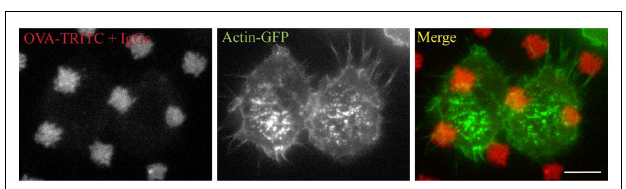
FIGUREA1 | Fc-receptors are necessary to trigger frustrated phagocytosis. RAW267.4 macrophage stably expressing GFP-actin (green) were pre-treated with anti-CD16/CD32 blocking antibodies, layered on micro-patterned immune complexes (red) for 15 minutes before being